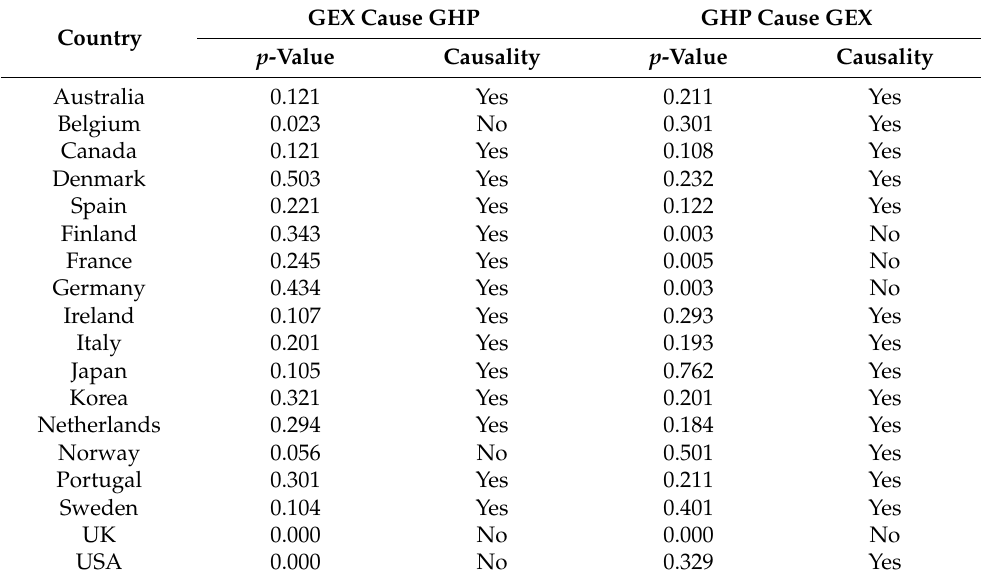
Table 4. The results of quantile Granger causality between housing prices and exchange rates in the boom market in OECD countries (quantile =